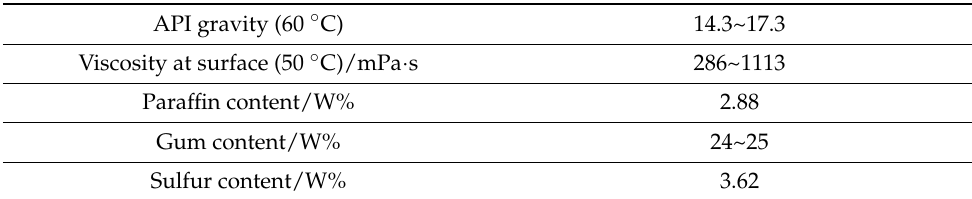
Table 1. Oil analysis, Q Oilfield.